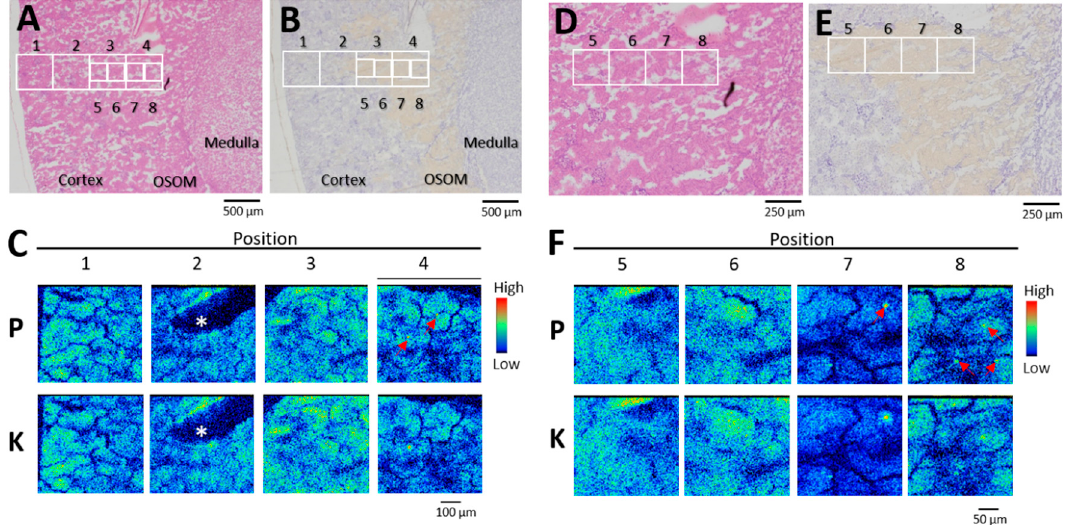
Figure 2. Phosphorus and potassium distribution in kidney on day 1 post-administration of uranyl acetate (UA) (2 mg kg − 1 ). ( A , D ) Serial sections stained with hematoxylin and eosin. ( B , E ) Serial sections stained for glutamine synthetase. Yellow tubules, S3 segments of the proximal tubule. ( C ) Elemental imaging (scanned area, 500 µ m × 500 µ m; integrated current, 0.2 µ C; beam size, 1 µ m × 1 µ m) in boxed areas 1–4 (A and B). ( F ) Elemental imaging (scanned area, 250 µ m × 250 µ m; integrated current, 0.2 µ C; beam size, 1 µ m × 1 µ m) of boxed areas 5–8 (D and E). P, phosphorus; K, potassium. Arrows, phosphorus concentrated areas. *Artificial crack. The periphery of the renal cortex is on the left side of all